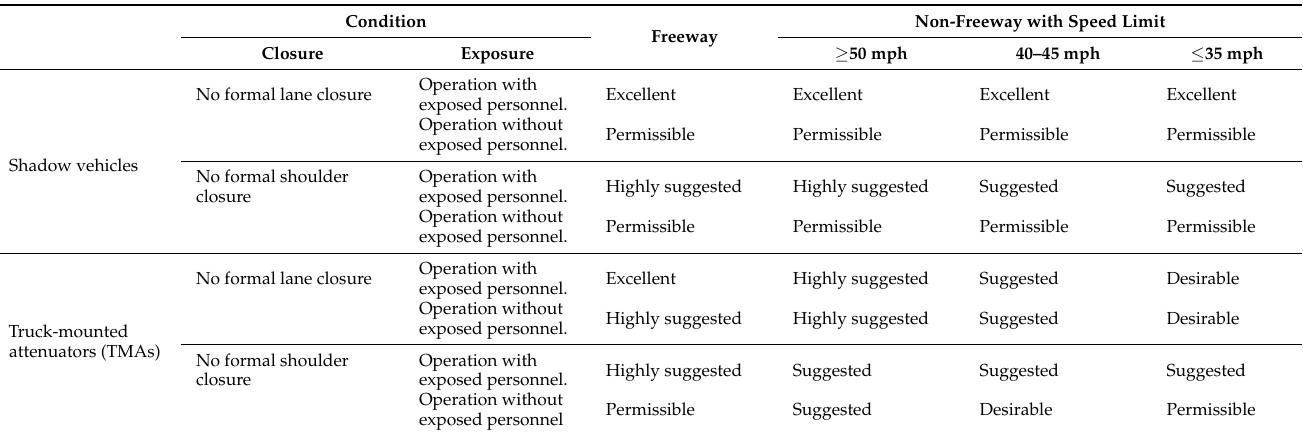
Table 2. Recommendations for the assignment of shadow vehicles and application of truck-mounted attenuators in work zones